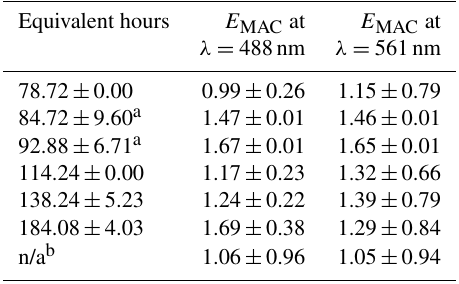
(cid:113) oxidation